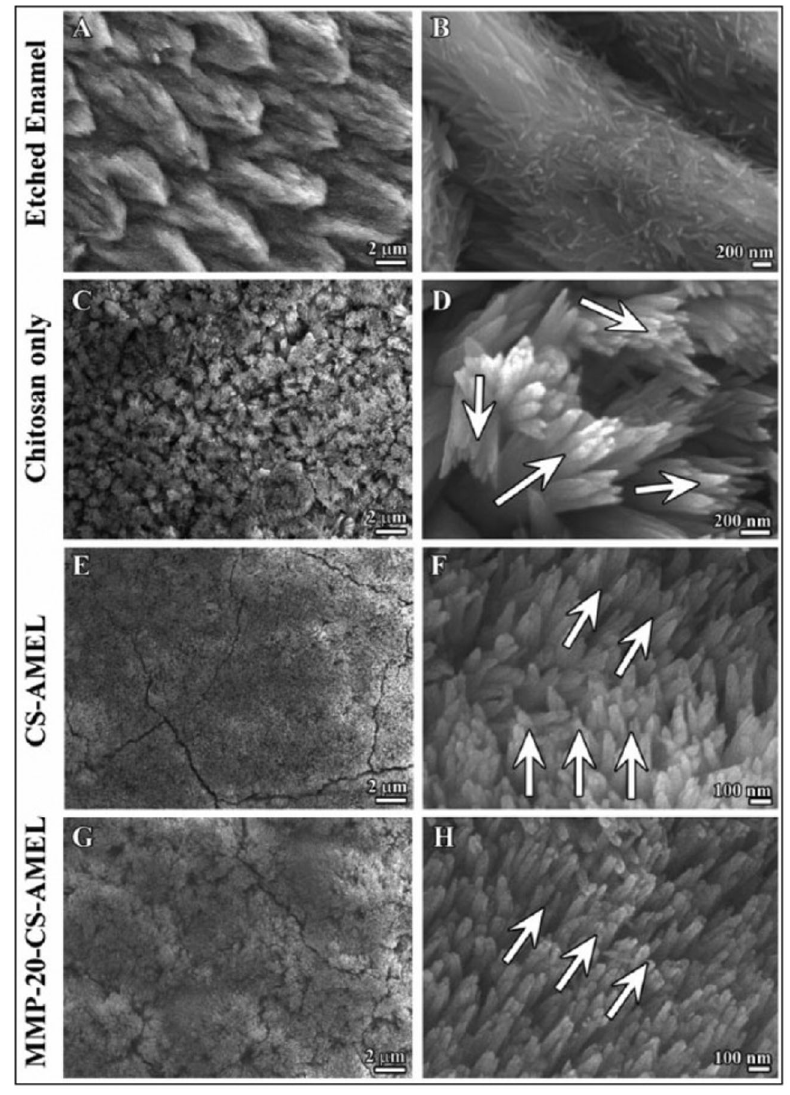
Fig. 3 Microstructure of enamel- like apatite crystals in the newly grown layer. Scanning electron microscopy (SEM) images showing A, B etched enamel, newly grown hydroxyapatite crystals in CS ( C, D ), AMEL- CS hydrogel ( E, F ) and AMEL- CS-MMP-20 ( G, H ). Arrows in D, H and F indicate the crystal orientation